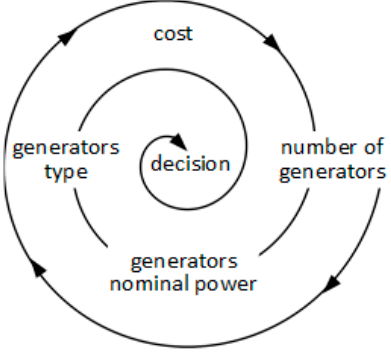
Figure 1. Typical genset selection process.